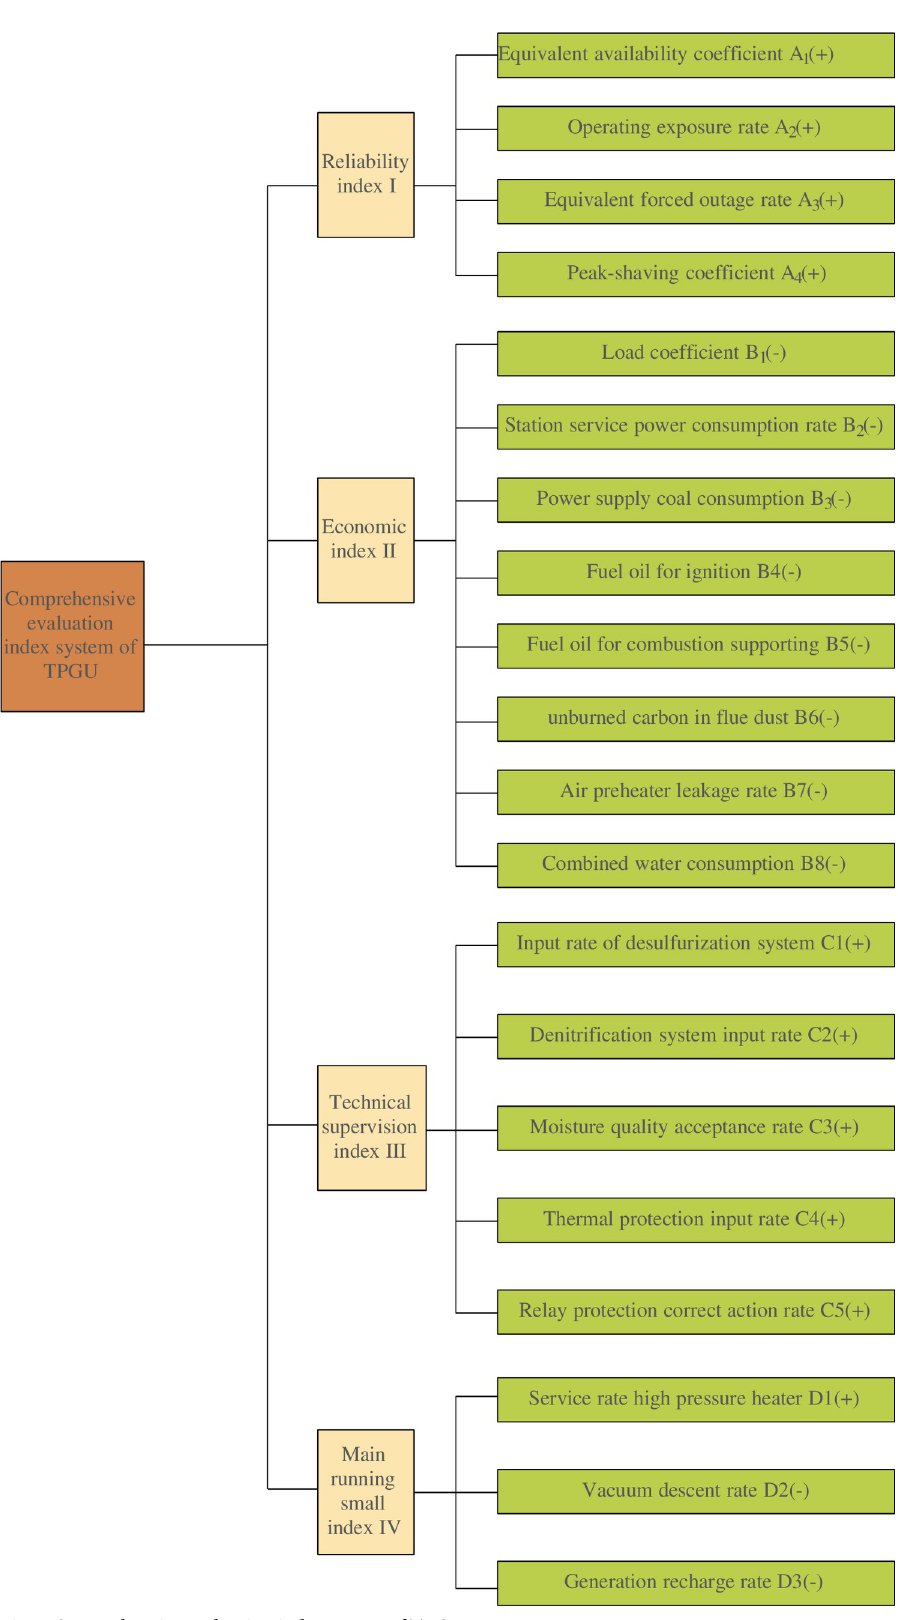
Fig 1. Comprehensive evaluation index system of